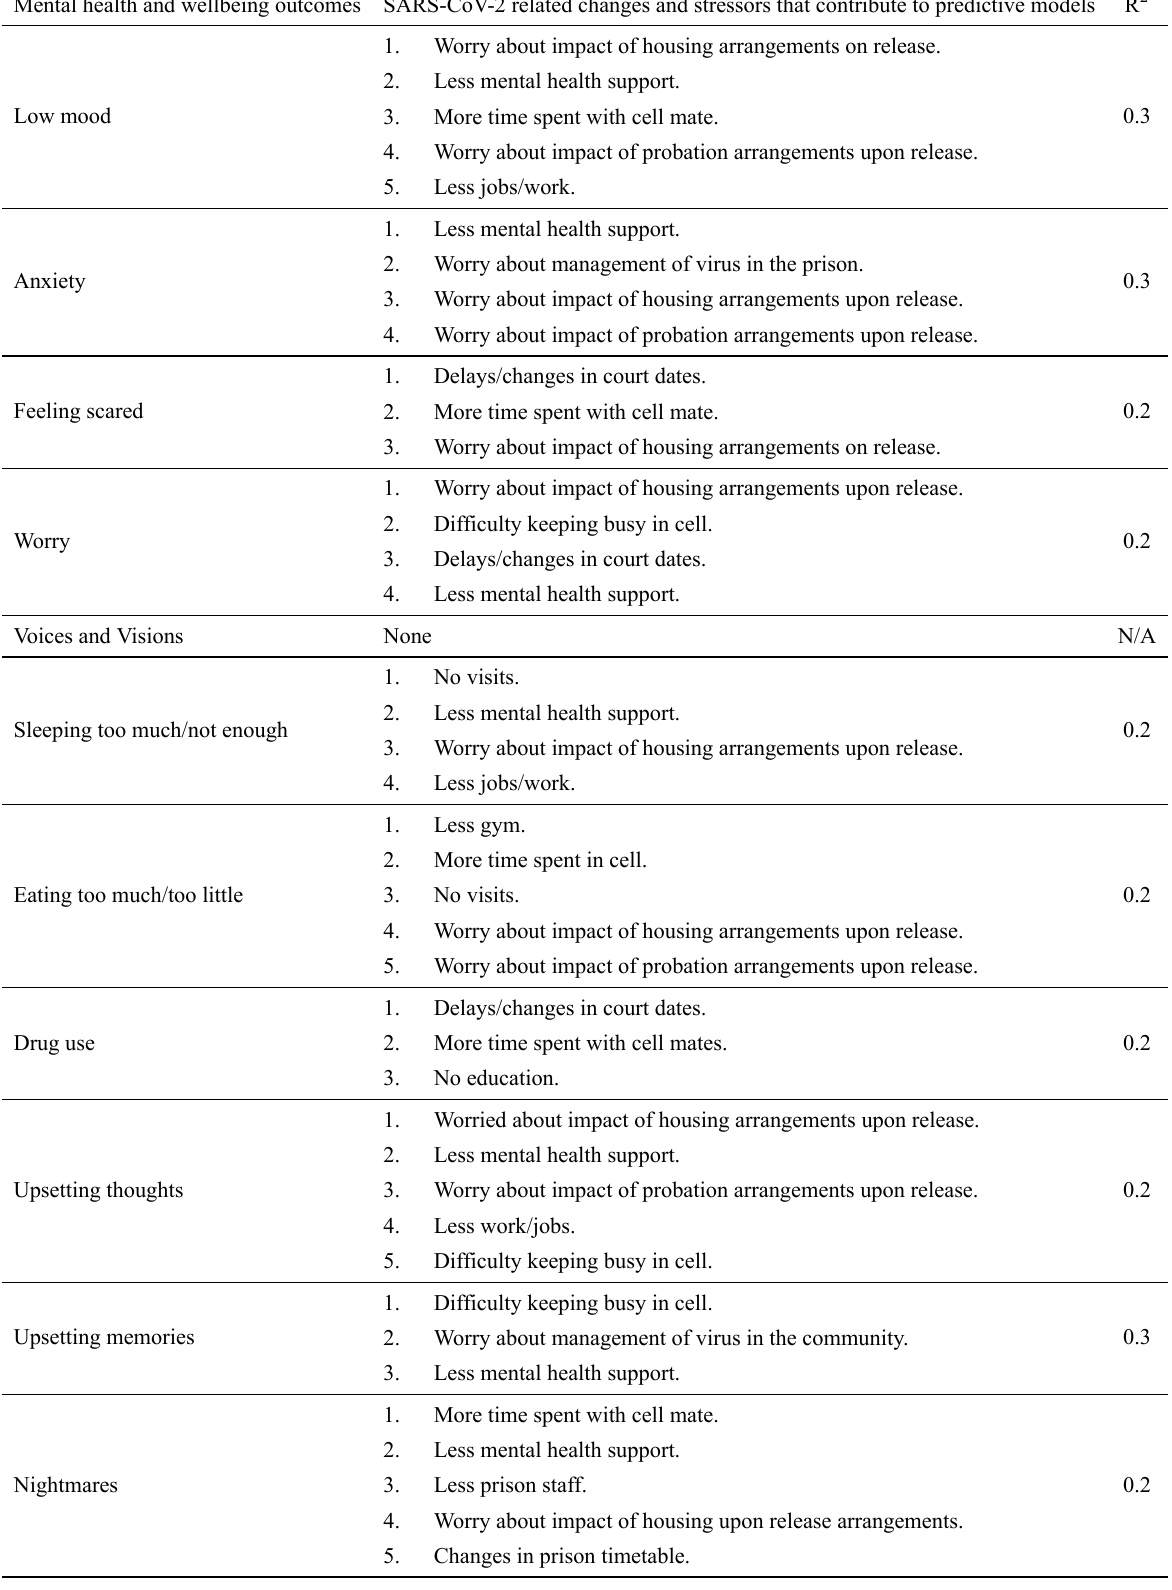
Table 4. Predictive models for mental health and wellbeing outcomes identified through feature selection and showing the amount of variation predicted by the model (R 2